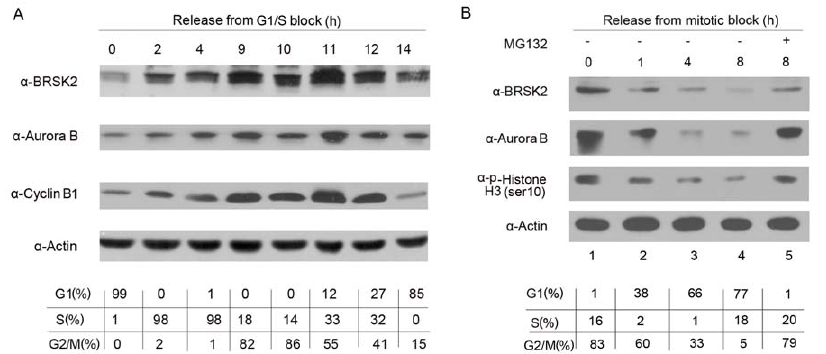
Figure 2. BRSK2 protein levels fluctuate during the cell cycle. (A) HeLa cells were arrested at the G1-S boundary by a double-thymidine block, released into fresh medium, and harvested at the indicated time points. Cell lysates were probed by Western blot (WB) with BRSK2, Aurora B, Cyclin B1, and b -actin antibodies. b -actin served as a loading control. (B) HeLa cells were arrested at prometaphase by a thymidine-nocodazole treatment, released into fresh medium, and harvested at the indicated time points. Cell lysates were probed by Western blot (WB) with BRSK2, Aurora B, p- Histone H3(Ser10), and b -actin antibodies. Cells were treated with MG132 (20 m M) for 8 h during the mitotic exit phase. Cell cycle stages in (A) and (B) were determined by flow cytometry and are indicated in the